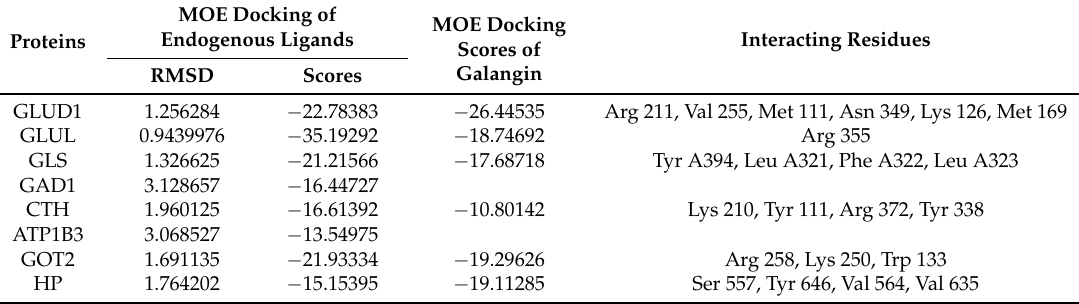
Table 5. Molecular docking of galangin into the binding pockets of related